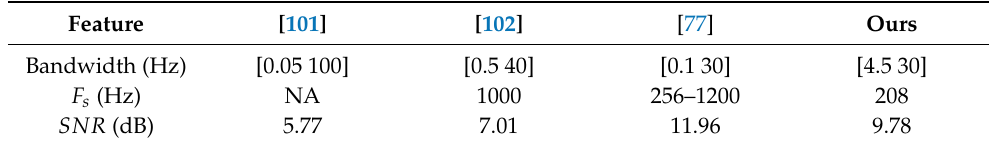
Table 9. Comparative with other low-cost ECG circuits.